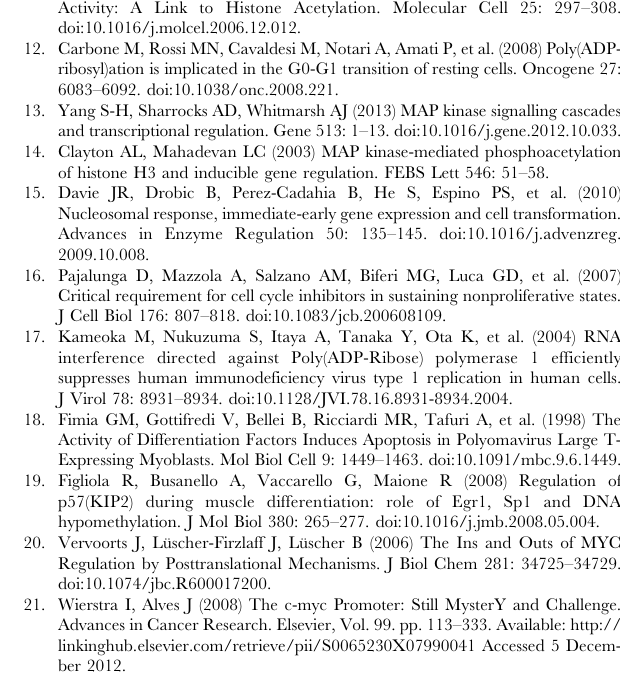
Figure S3 PARP-activity is required for histone modifi- cations at c-MYC promoter. Acetyl histone H3 (AcH3) and phospho-acetyl histone H3 (pAcH3) levels at c-MYC promoter assessed by ChIP-qPCR. Chromatin samples were obtained from quiescent (-FBS) or 30 minutes serum-stimulated ( + FBS) fibro- blasts treated or not with PJ-34, and immuno-precipitated with an antibody specific for AcH3, pAcH3 or total H3. Values of modified histones were normalized respect to those of total H3 in the same promoter region (fragment fr.2 + 3). The error bars represent the SD of three technical replicates. Table S1 Primers for RT-qPCR. Table S2 Primers for ChIP and DNAseI